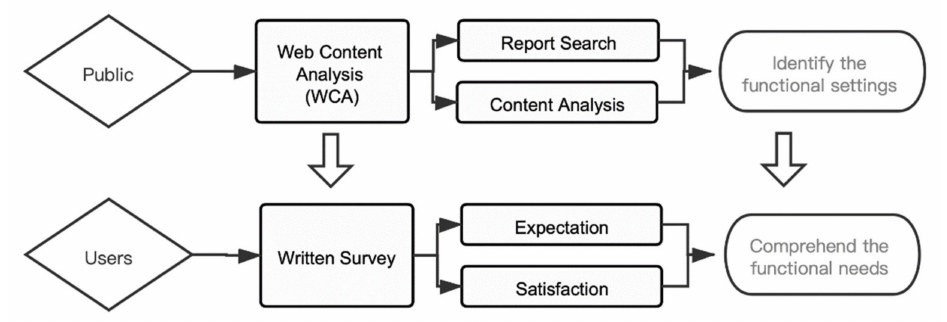
Figure 1. Research